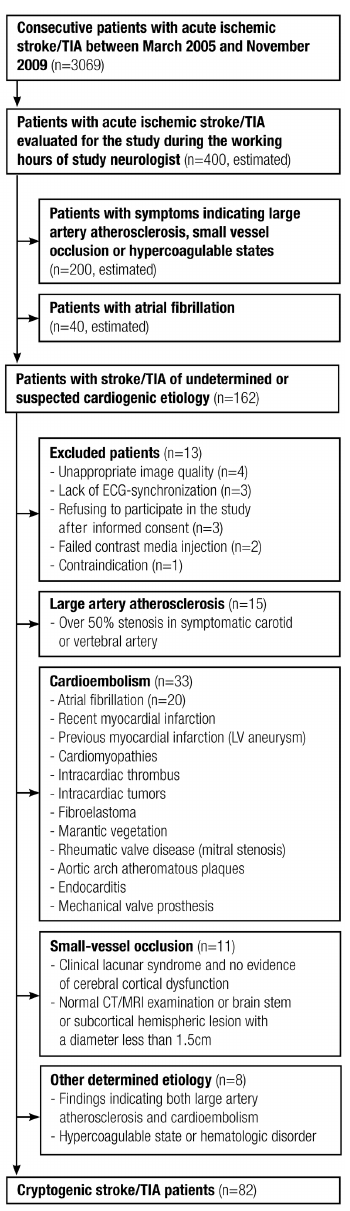
Figure 1. Flow chart of patient recruitment. Neurologists recruited consecutive patients with acute ischemic stroke/TIA with undetermined etiology or a suspicion of cardiogenic etiology. Stroke/TIA patients with atrial fibrillation were excluded. Thirteen patients were excluded from the study after recruitment. The remaining patients were subjected to thorough clinical, cardiological and radiological examinations. Patients were further categorized according to the TOAST classification, denoting five subtypes of ischemic stroke: 1) large-artery atherosclerosis, 2) cardioembolism, 3) small-vessel occlusion, 4) stroke of other determined etiology, and 5) stroke of undetermined etiology. The classification was updated by applying the more recent EAE recommendations for defining cardiac sources of